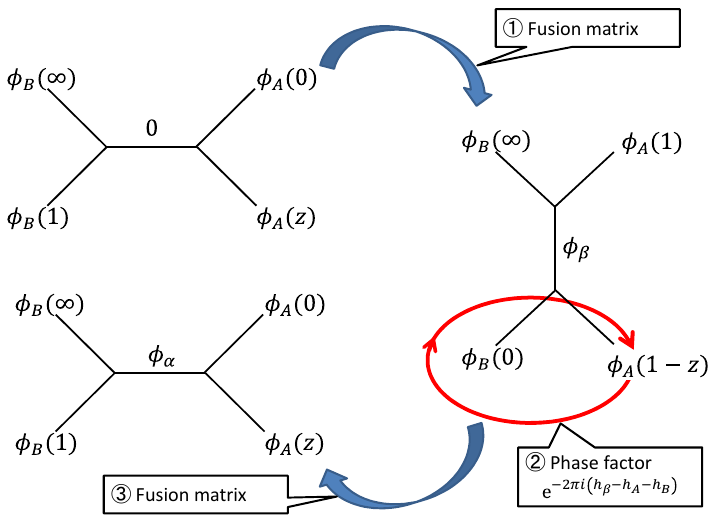
Figure 3 . The monodromy matrix is given by three steps; (1) fusion transformation, (2) picking up a trivial phase factor, and (3) fusion